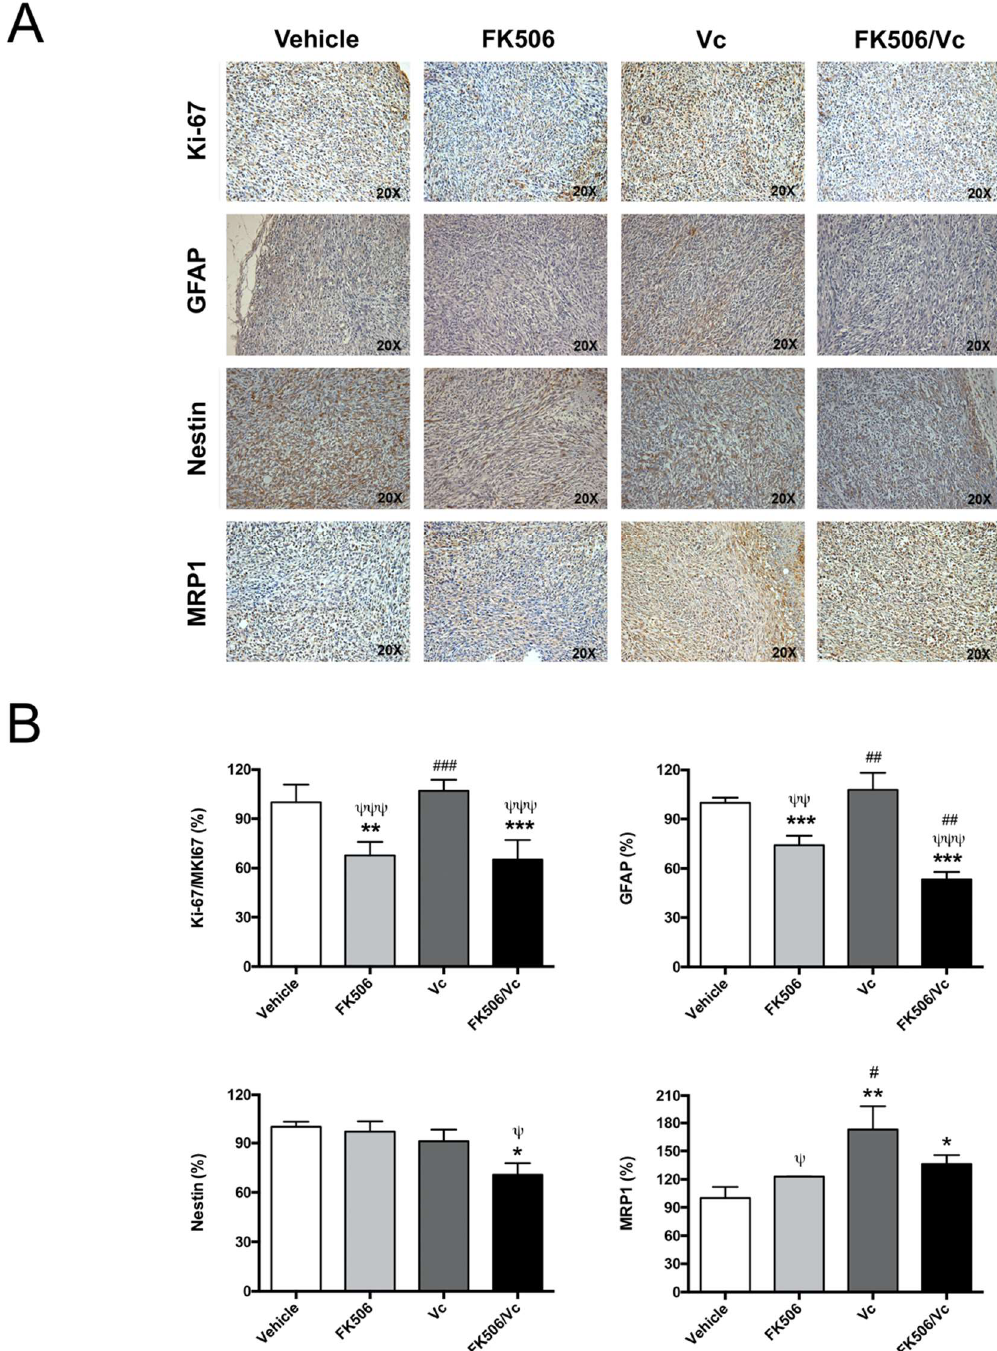
Figure 5. Vincristine in co-treatment with FK506 decreases tumor markers in vivo. ( A ) An immunohistochemistry assay was performed with tumor samples obtained after seven days of treatment (see Figure 4) against Ki-67, Glial Fibrillary Acidic Protein (GFAP), nestin, and MRP1; ( B ) graphs represent the quantification of A as a percentage of expression. Graphs represent the mean ± S.D. * p < 0.05; ** p < 0.01 and *** p < 0.001 versus vehicle. # p < 0.05; ## p < 0.01 and ### p < 0.001 versus FK506. ψ p < 0.05; ψψ p < 0.01 and ψψψ p < 0.001 versus Vc. n = 4.